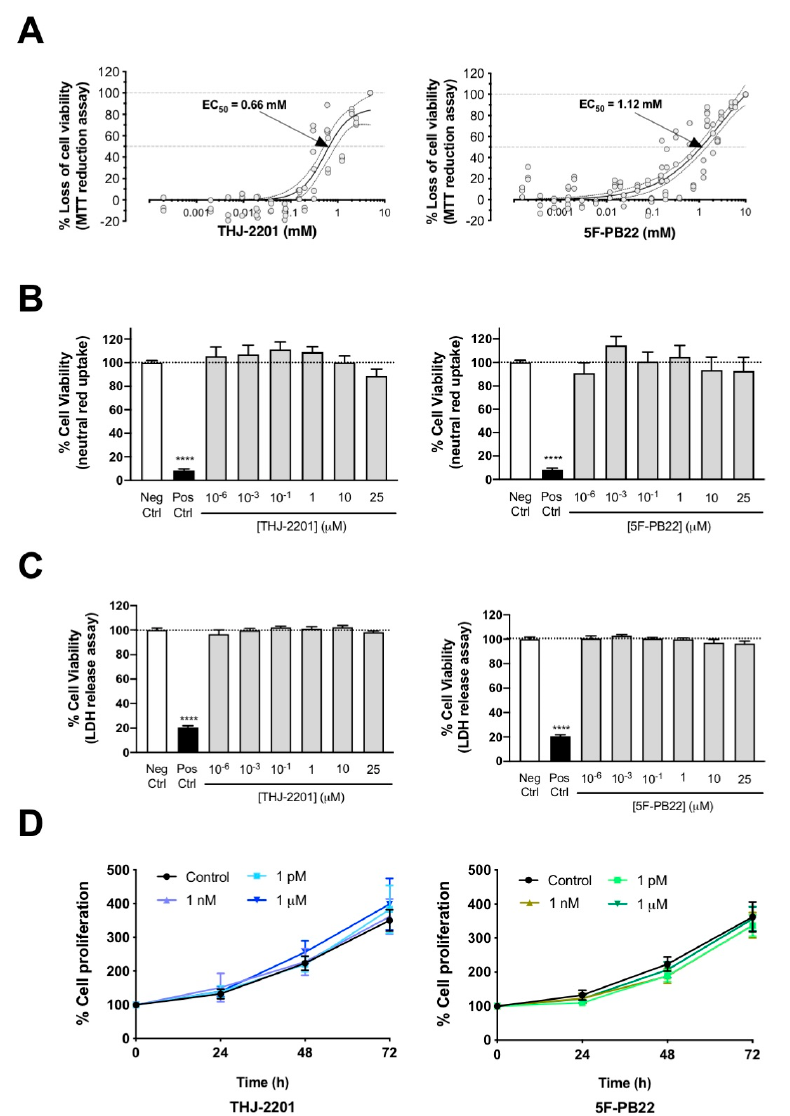
Figure 1. Cell viability and proliferation assessed in NG108-15 cells exposed to either THJ-2201 or 5F-PB22. Distinct biomarkers of cell viability were determined after 24 h-exposure at a range of drug concentrations described in Materials and Methods. ( A ) Metabolic activity, assessed by the 3-(4,5-dimethylthiazol-2-yl)-2,5-diphenyltetrazolium (MTT) reduction assay. Each concentration was tested in triplicate in four independent experiments. EC 50 is the drug concentration that induces half-maximal response (i.e., 50% e ff ect); ( B ) Lysosomal integrity, analyzed by the neutral red uptake assay. Each bar represents the mean ± SEM, for at least six independent experiments, performed in duplicate. **** p < 0.0001, compared to the control (0.1% DMSO), using an unpaired, two-tailed t -test. No statistically significant di ff erences were observed for any of the SC concentrations tested, using an one-way ANOVA, followed by Dunnett’s post-test; ( C ) Membrane integrity, evaluated by the lactate dehydrogenase (LDH) release assay. Each bar represents the mean ± SEM, for at least six independent experiments, performed in duplicate. **** p < 0.0001, compared to the control (0.1% DMSO), using an unpaired, two-tailed t -test. No significant di ff erences were noted for any of the SC concentrations tested (one-way ANOVA, followed by Dunnett’s post-test). ( D ) Cell proliferation indicated by the sulforhodamine B assay, followed drug exposure up to 72 h. For each concentration, the mean ± SEM for at least three independent experiments is represented. No statistically significant di ff erences were found between the di ff erent concentrations shown and the respective controls, for each time point (one-way ANOVA, followed by Dunnett’s